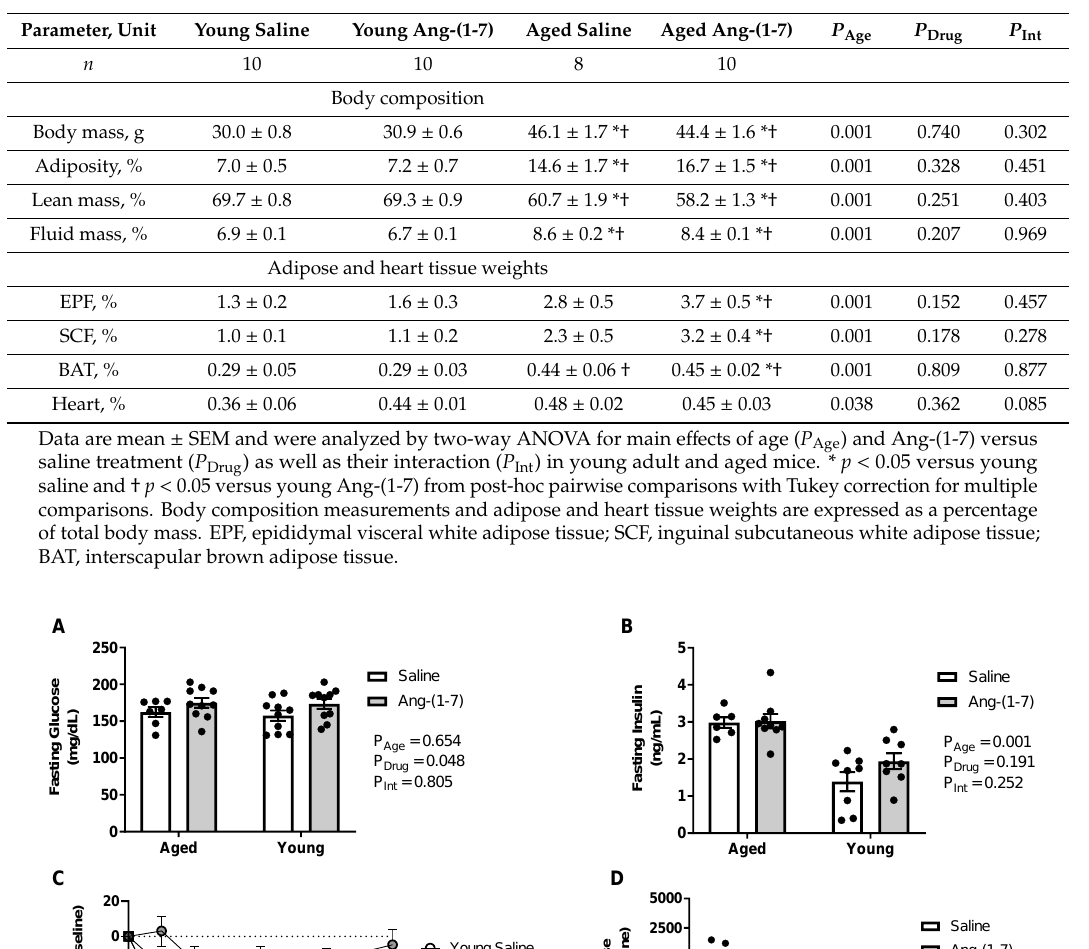
Data are mean ± SEM and were analyzed by two-way ANOVA for main effects of age ( P Age ) and Ang- (1-7) versus saline treatment ( P Drug ) as well as their interaction ( P Int ) in young adult and aged mice. * Table 1. Angiotensin (Ang)-(1-7) and body composition in aged mice. p < 0.05 versus young saline and † p < 0.05 versus young Ang-(1-7) from post-hoc pairwise Parameter, Unit Young Saline Young Ang-(1-7) Aged Saline Aged Ang-(1-7) P Age P Drug P Int comparisons with Tukey correction for multiple comparisons. Body composition measurements and adipose and heart tissue weights are expressed as a percentage of total body mass. EPF, epididymal visceral white adipose tissue; SCF, inguinal subcutaneous white adipose tissue; BAT, interscapular brown adipose tissue.